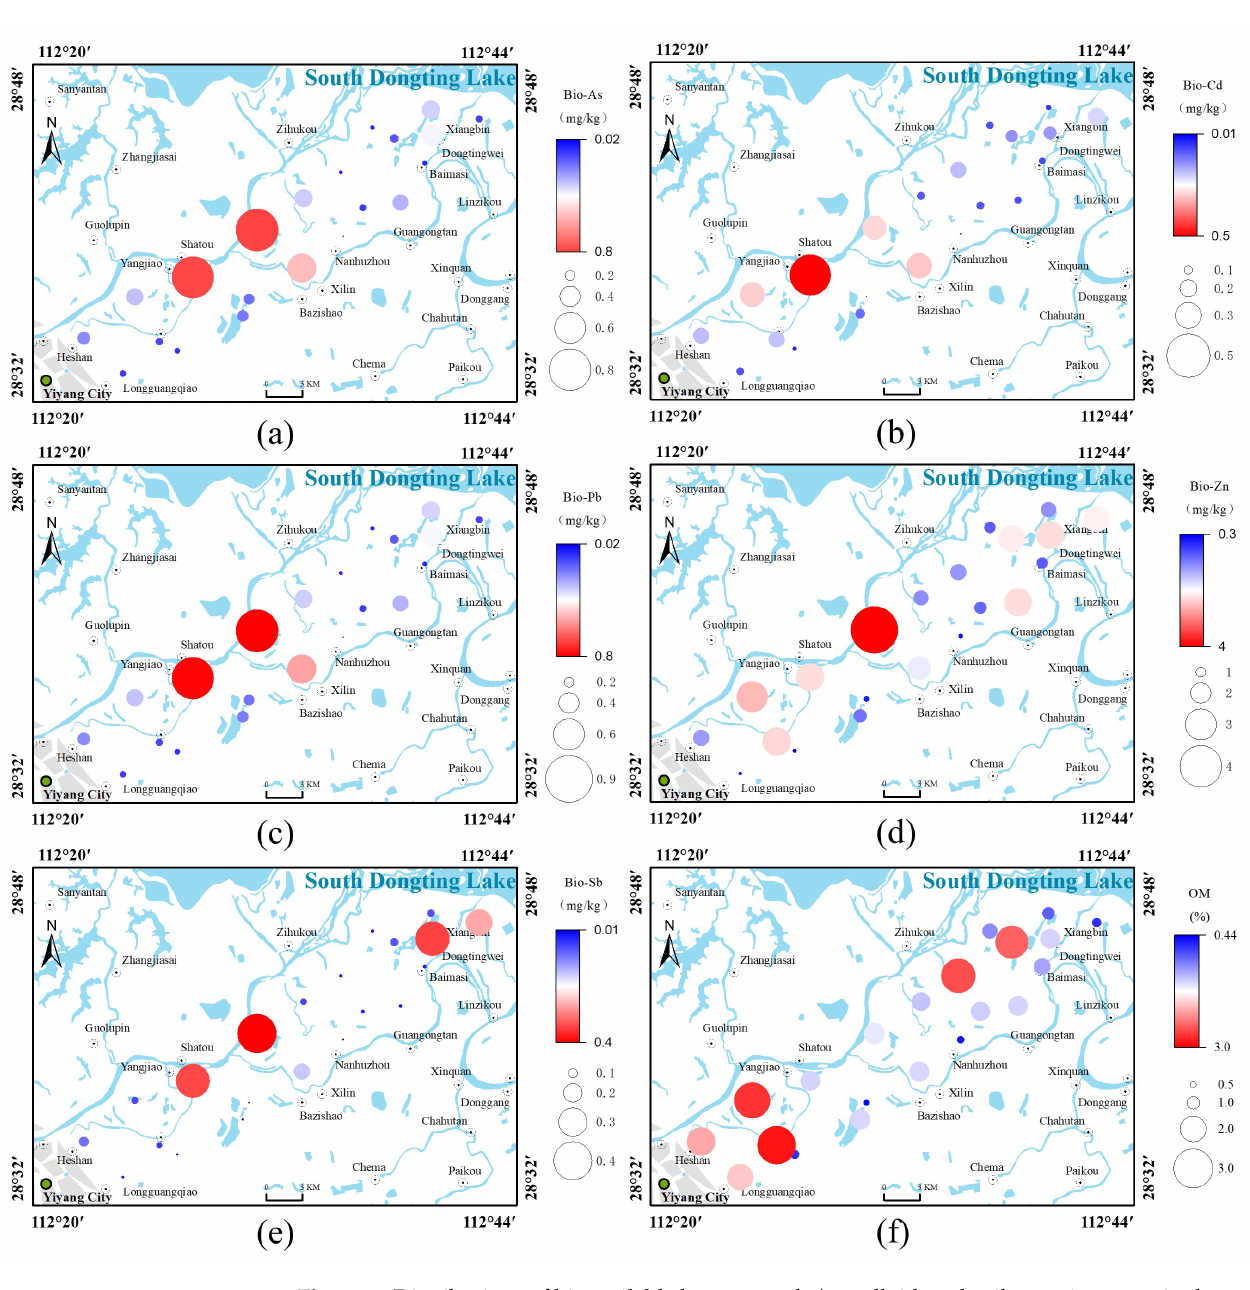
Figure 3. Distributions of bioavailable heavy metals/metalloidsand soil organic matter in the study area: ( a ) As, ( b ) Cd, ( c ) Pb, ( d ) Zn, ( e ) Sb, and ( f ) organic